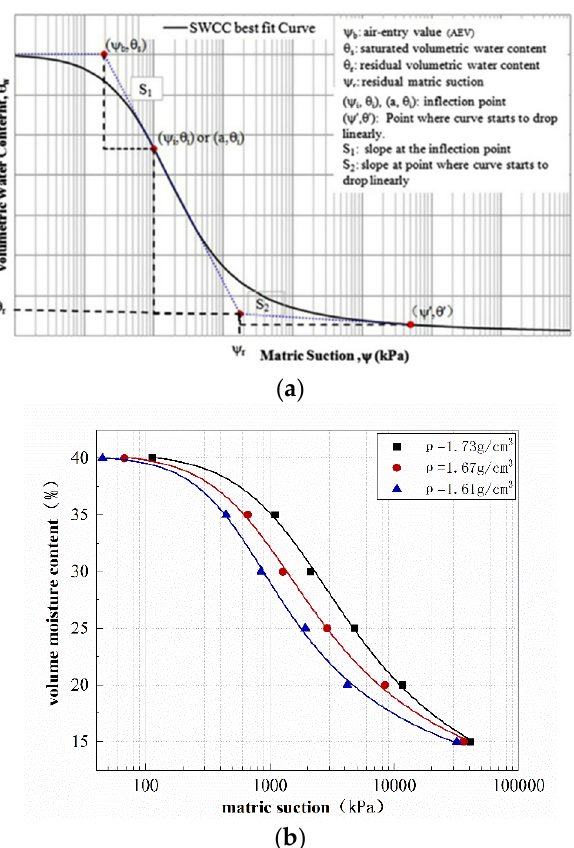
Figure 4. ( a ) Typical SWCC in the semi-logarithmic coordinate diagram [20]. ( b ) SWCCs of low- liquid-limit silty clays at three densities without freeze–thaw cycles.